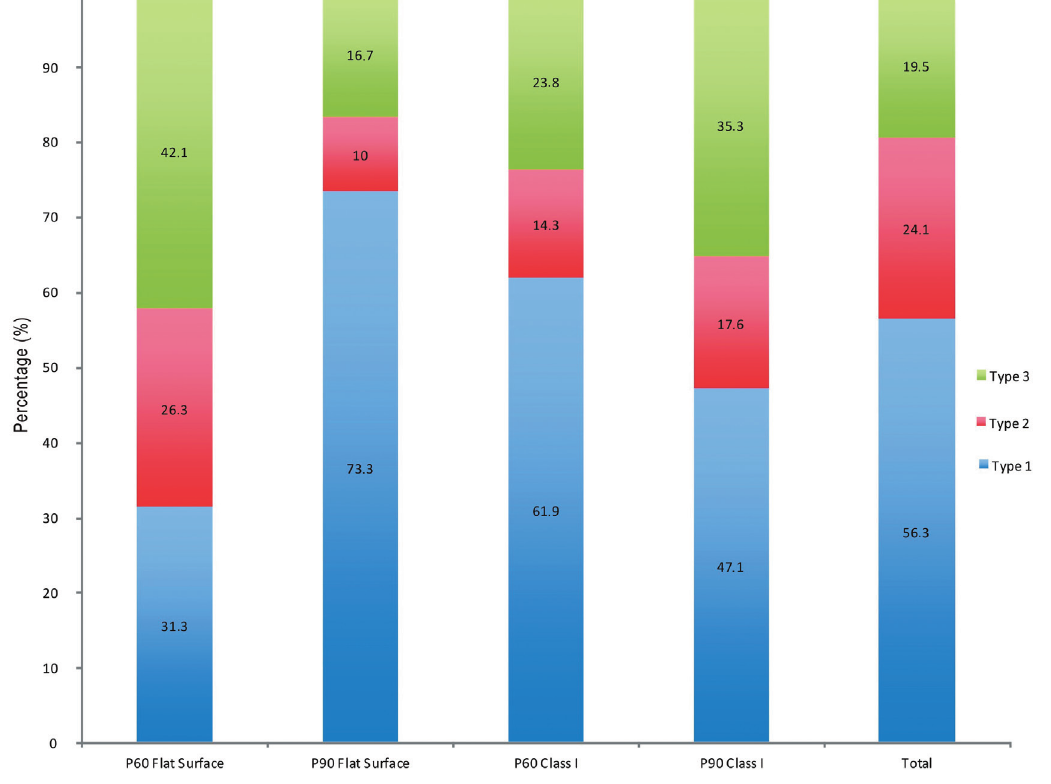
Figure 3- Percentage of fracture patterns. Type 1: Adhesive fracture; Type 2: Partially adhesive fracture and partially cohesive in the adhesive; Type 3: cohesive fracture in resin